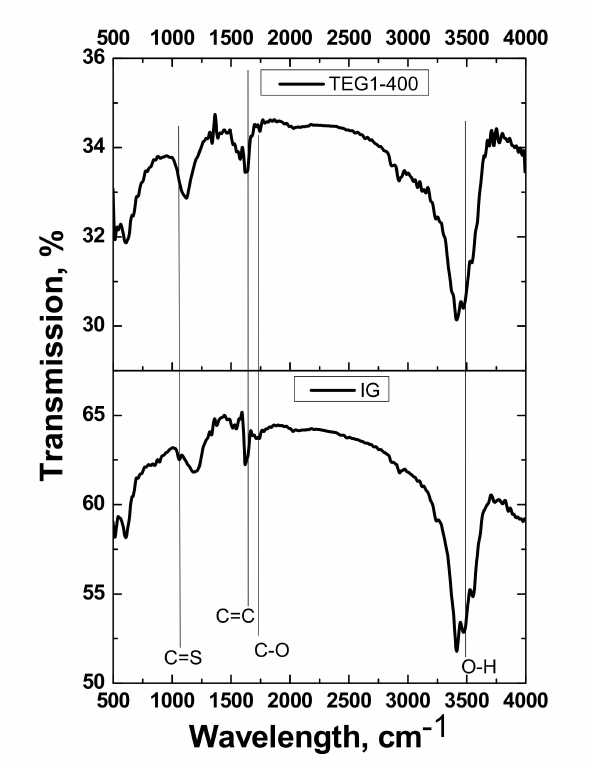
Figure 8. FTIR spectra of IG and